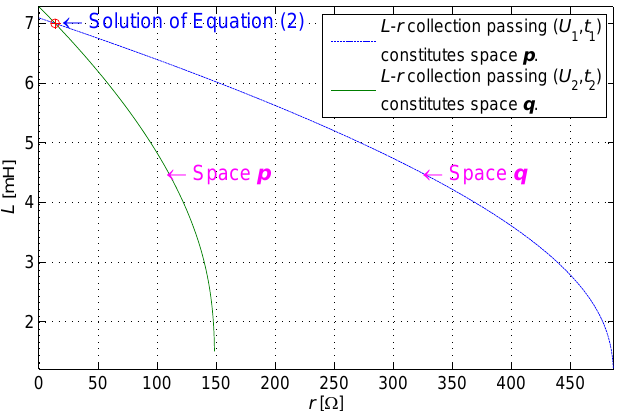
Figure 7. The intersection of spaces p and q as the solution of Equation